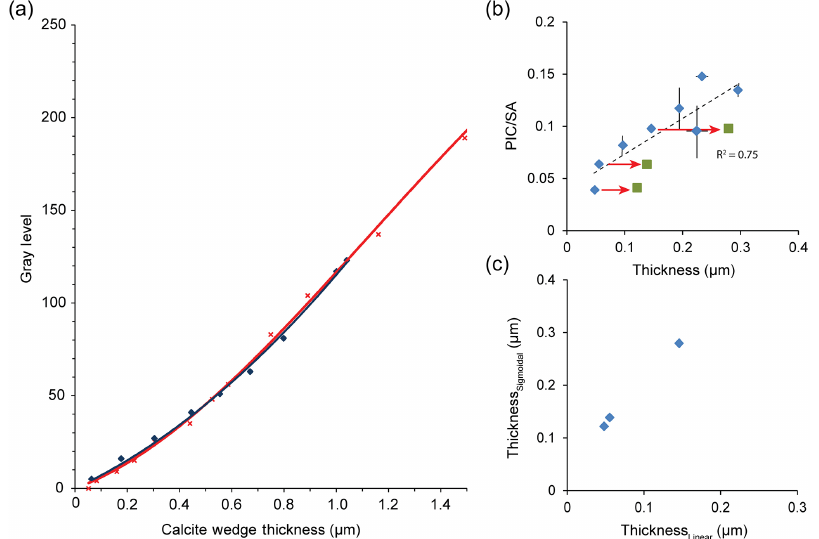
Figure 4. (a) Gray level vs. calcite wedge thickness on images taken with an 8-bit camera. The wedge shows the expected sigmoidal shape at low thicknesses. The reproducibility of the calcite wedge, on images taken under very similar microscopic conditions and light intensity on different moments, is very consistent. The blue line represents a calibration carried out on 29 October 2014, while the red line represents a calibration carried out on 15 July 2015. (b) Comparison of Emiliania huxleyi coccolith thickness estimates using linear and sigmoidal calibration forms. The graphic shows the relationship between cellular calcification (calcite per cell surface area) and coccolith thickness using linear calibration (blue symbols) and sigmoidal calibration (green symbols, connected by red arrows to the equivalent sample measured with linear calibration). (c) Comparison of linear and sigmoidal calibration for three populations of coccoliths from